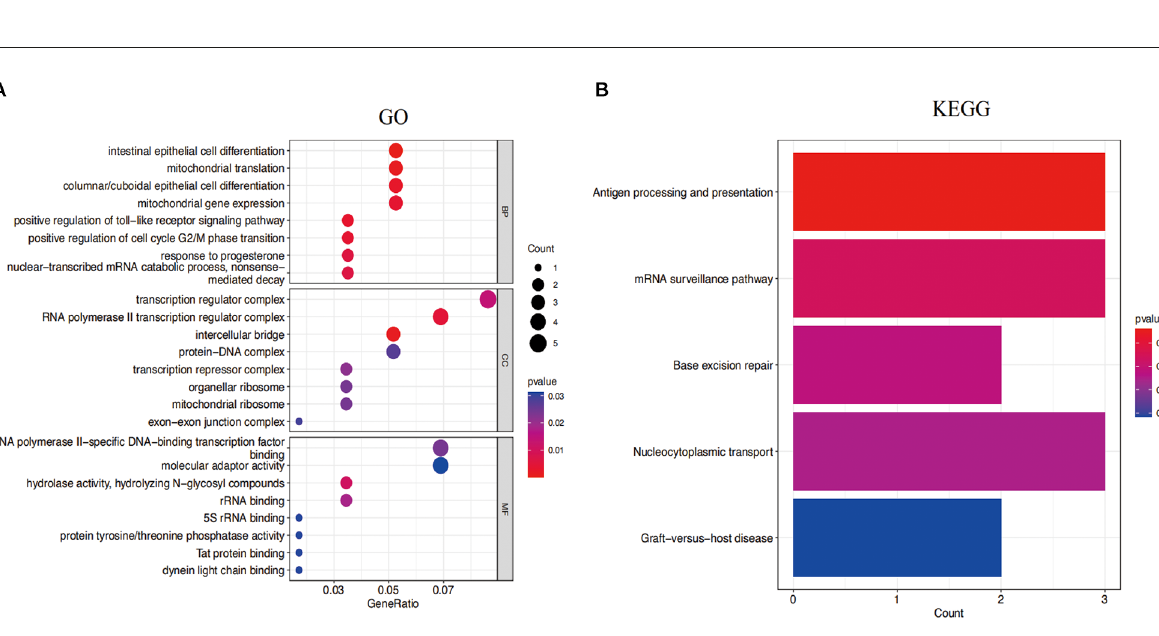
2013; Feng et al., 2021). Therefore, chronic insufficiency of vitamin D may accelerate the degeneration of dopaminergic neurons, especially in the substantia nigra region, thereby